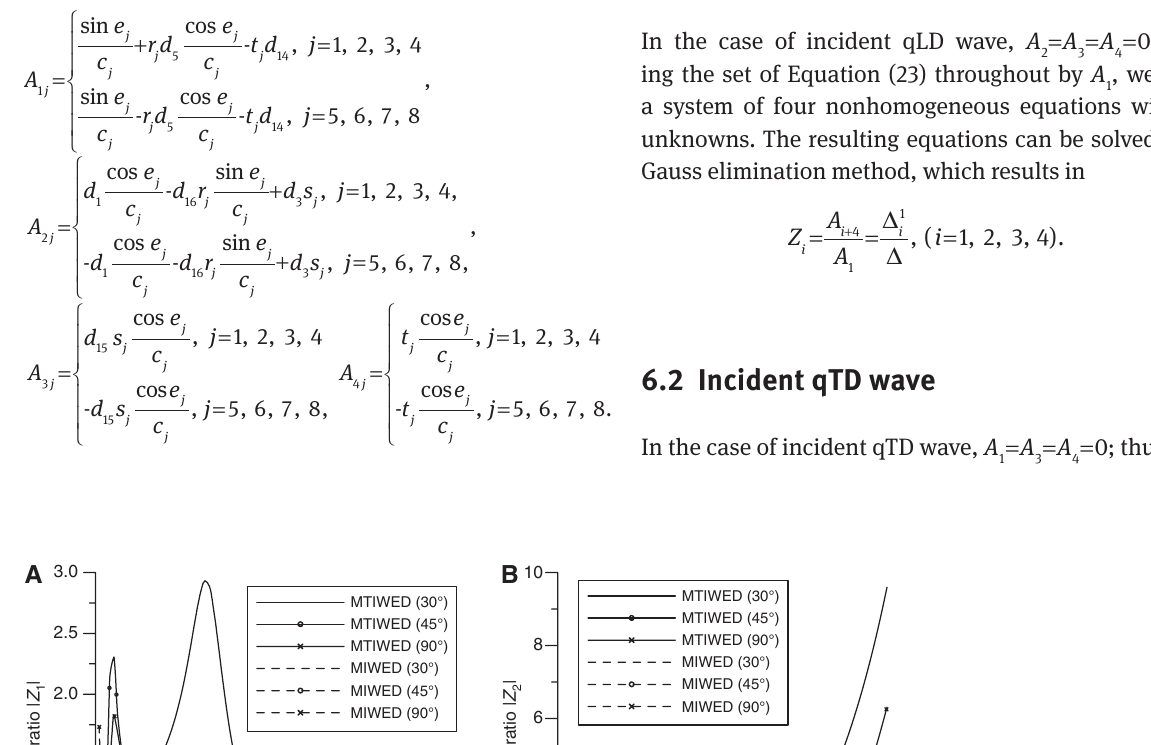
|, (C) amplitude ratio | Z 2